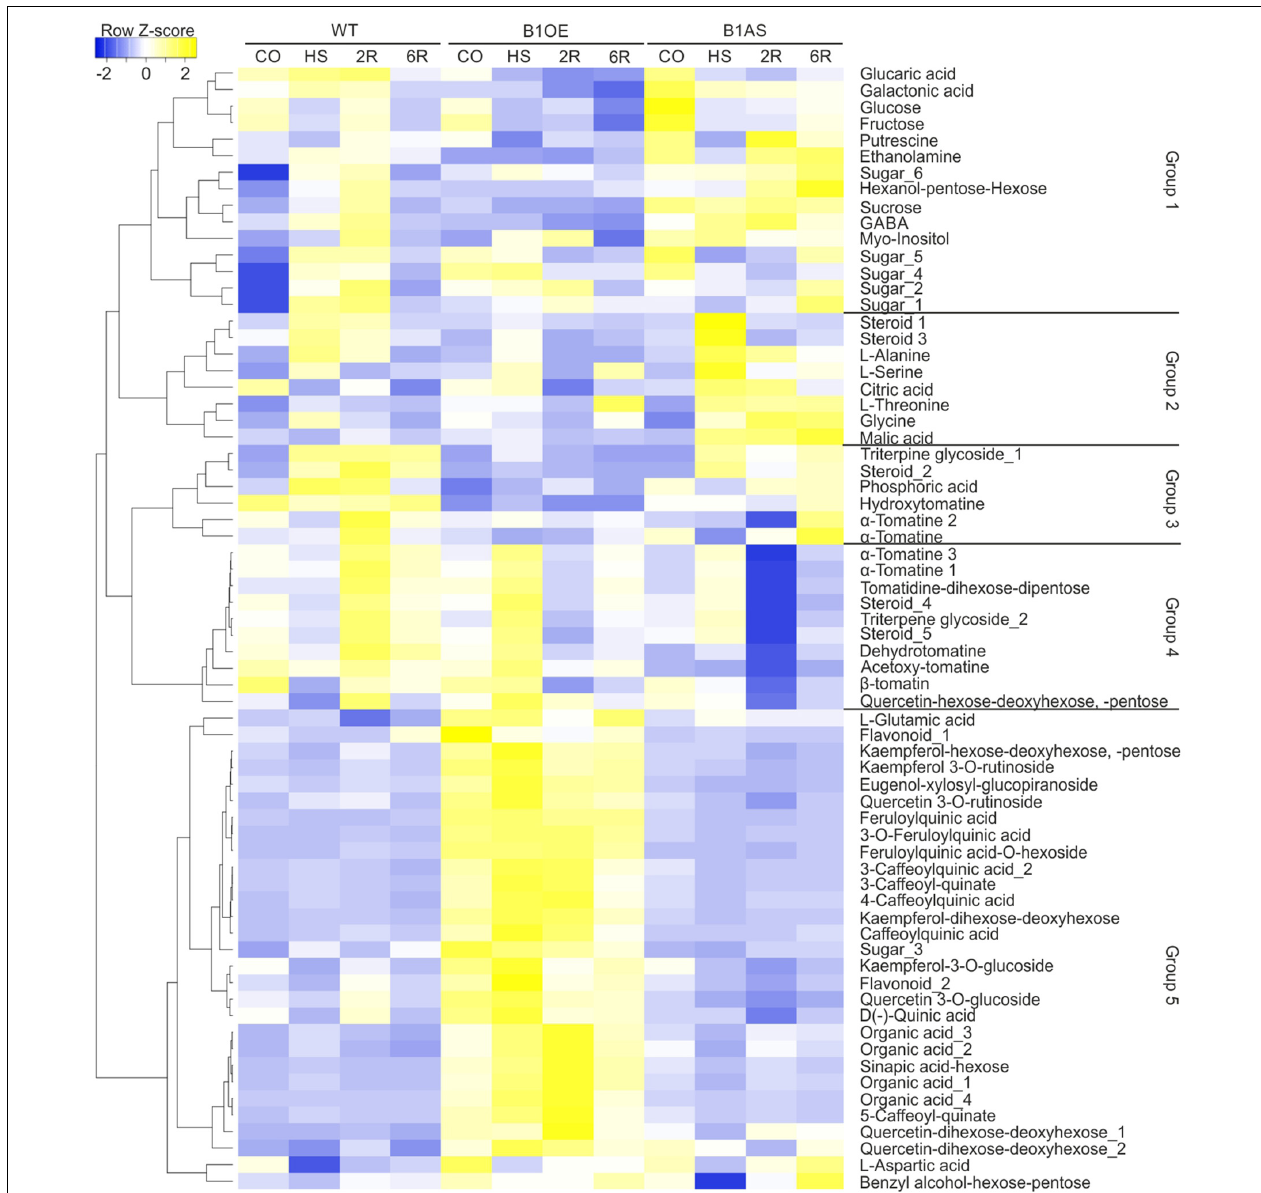
FIGURE 3 | Effect of HsfB1 overexpression or suppression on abundance of metabolites in tomato leaves exposed to heat stress. Annotated metabolites were grouped based on their profile in all samples and genotypes using complete linkage clustering method based on Pearson distance measurement. The dendrogram showing similarity in metabolite profiles was constructed by complete linkage clustering and distances were calculated by Pearson index. Metabolite levels are depicted as heat map constructed using heatmapper (Babicki et al., 2016). Annotated metabolites and groups are depicted on the